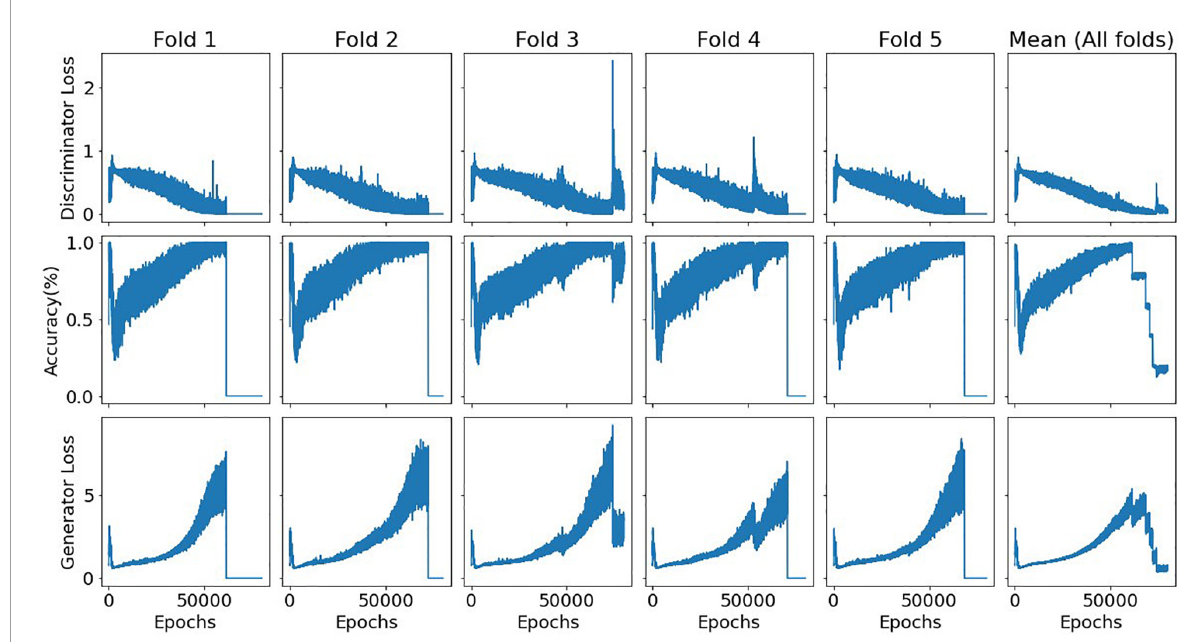
FIGURE5 Evolution of the discriminator accuracy and both discriminator and generator losses for a single DorsalAttn model with a triangular architecture. Relative consistency across folds is displayed, showing model stability, especially in terms of the bias-variance tradeoff for the discriminator subnetwork. In all folds except the third, it is noticeable when the training process was halted due to the predefined stop criterion. A seed number of 0 was used for this specific training process (set for both NumPy and Tensorflow